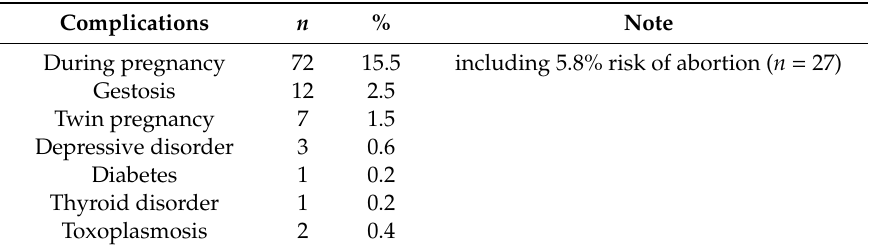
Table 4. Prenatal and perinatal